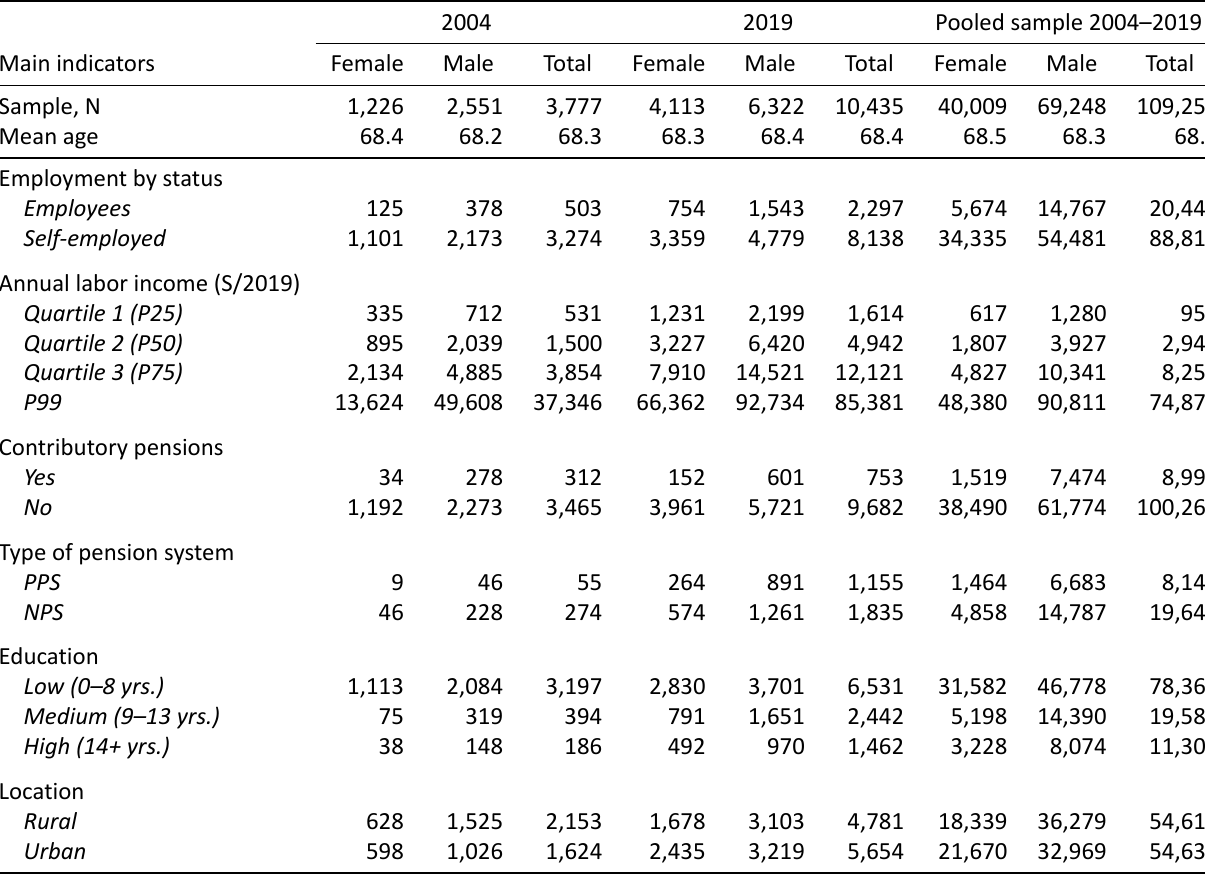
Table 2. Summary of main descriptive statistics 2004, 2019 and pooled sample from 2004 to